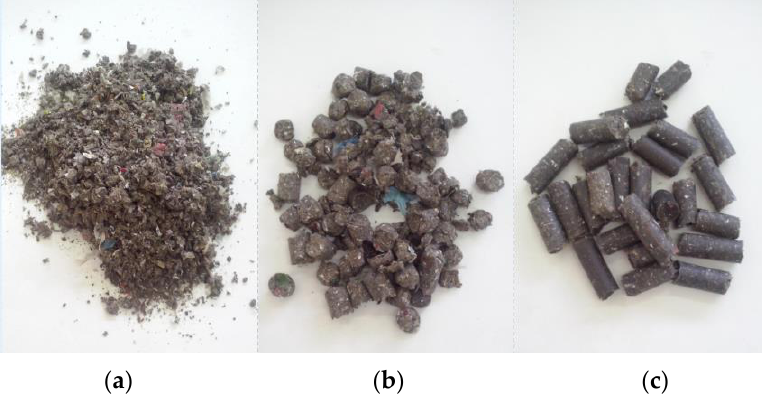
Figure 13. ( a ) Images of the raw RDF grist, ( b ) pellets from biomass die, and ( c ) from modified RDF die. Energies 2020 , 13 , 910